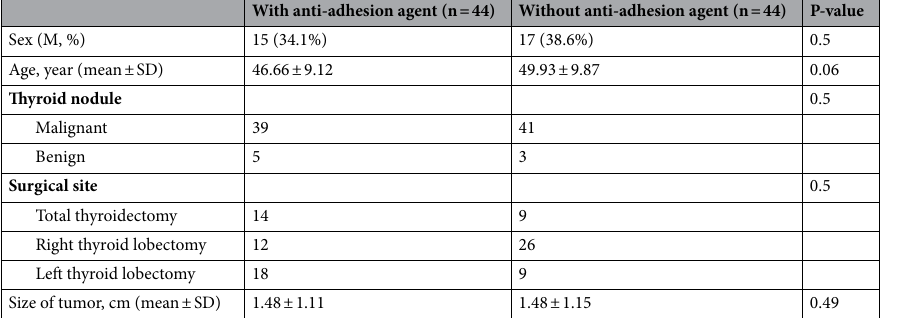
With anti-adhesion agent (n = 44) Without anti-adhesion agent (n = 44)